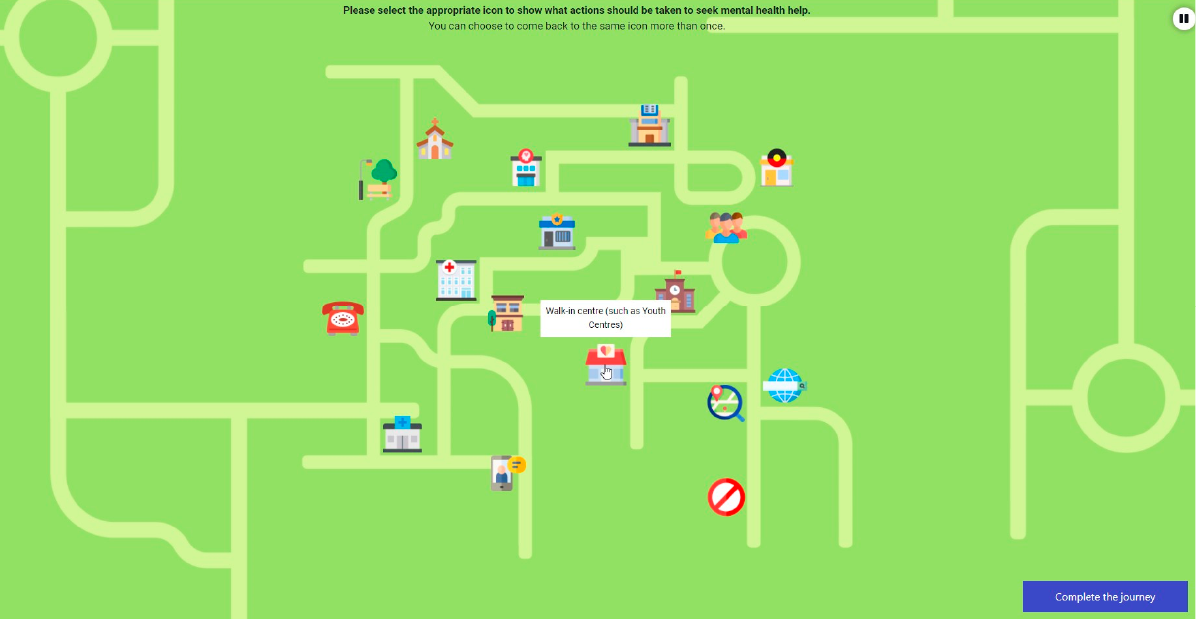
Figure 3. Preview of the patient journey mapping activity. Respondents will explore a fictional case study or will share their own personal experiences of how young people seek help and navigate their community’s youth mental health